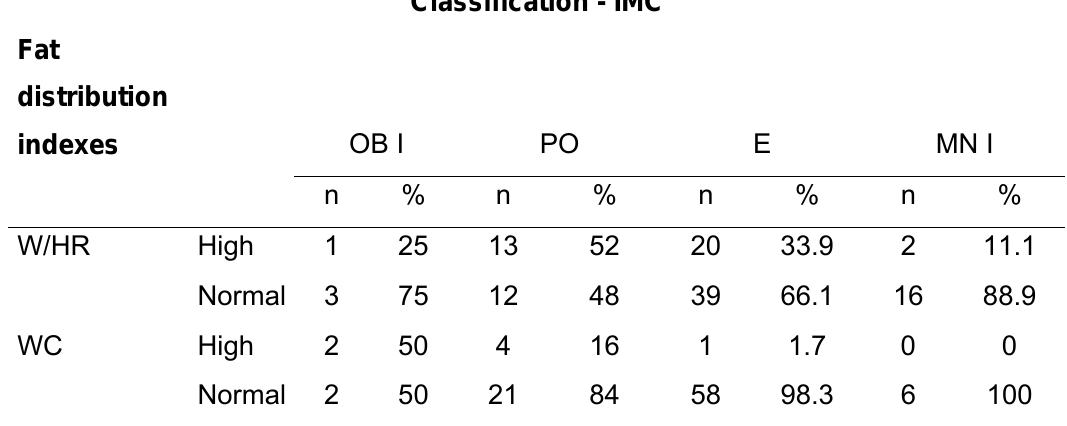
Classification - IMC